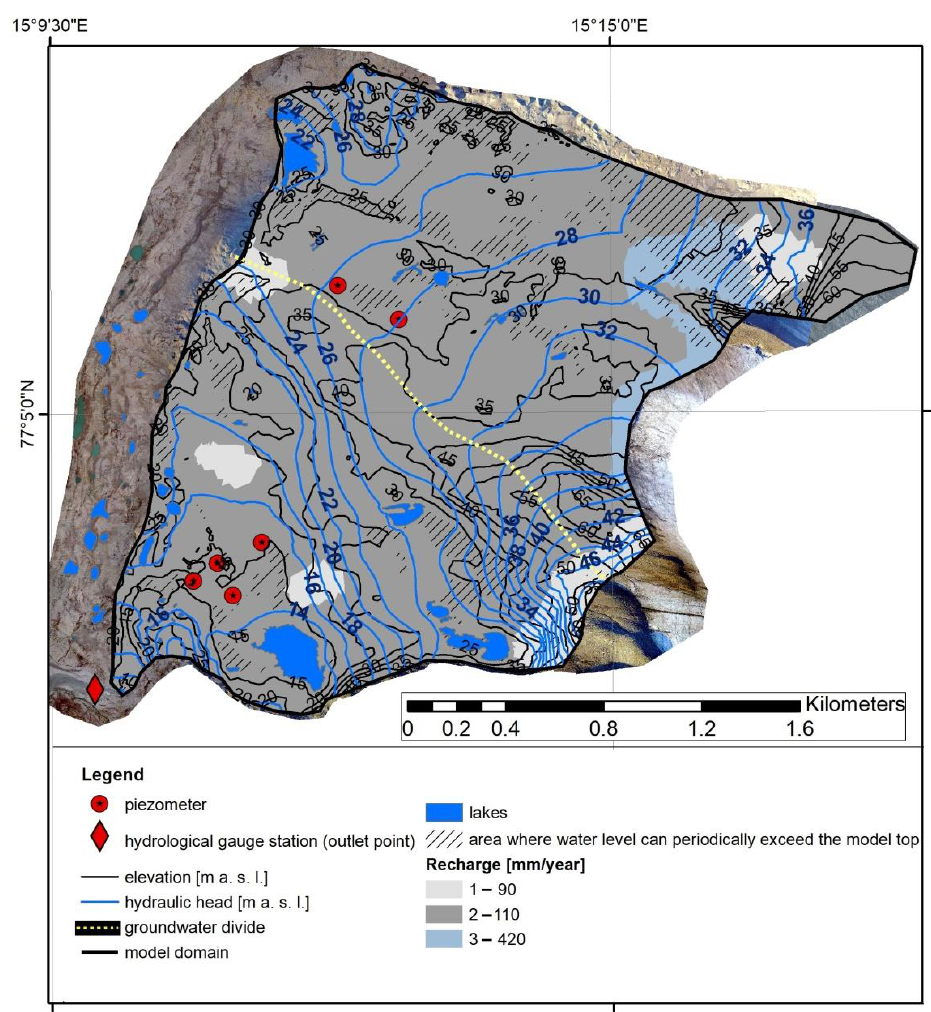
Figure 4. Calibrated hydraulic head distribution and groundwater recharge.